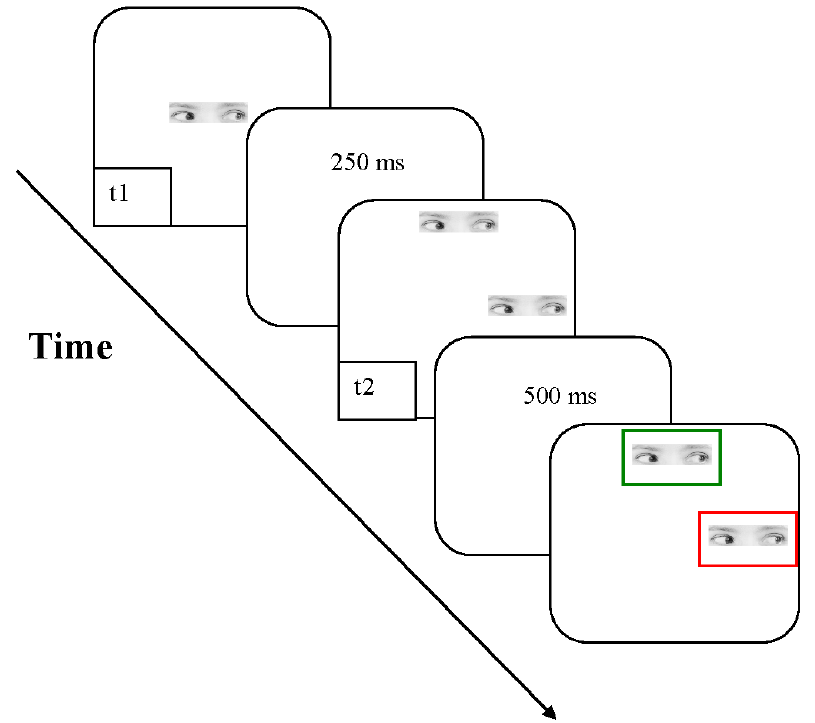
Figure 4. A schematic representation of the sequence of events in Experiment 1, with gaze as